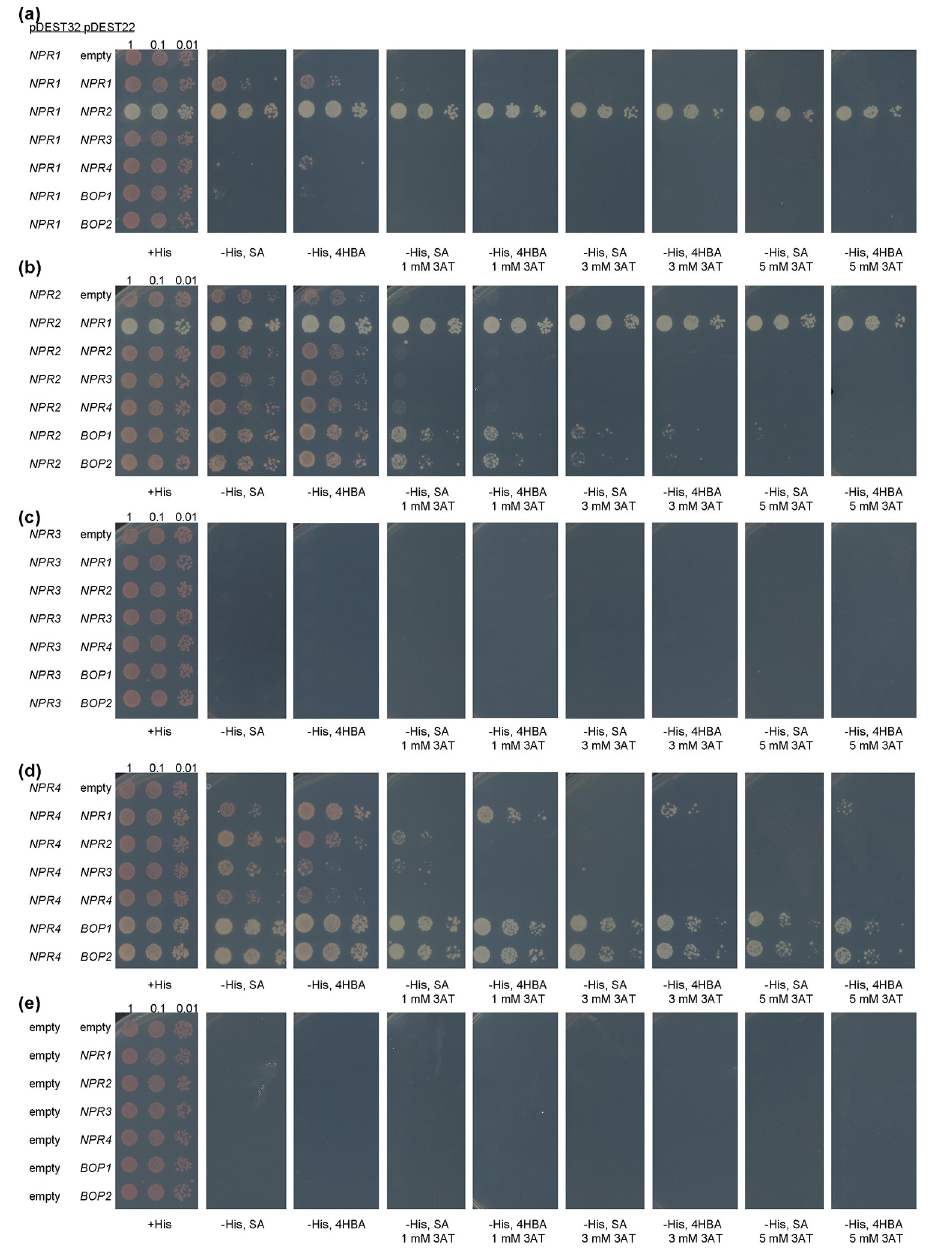
Fig 5. NPR1 paralogs in yeast two hybrid. (a) Interactions of NPR1 with the paralogs. (b) Interactions of NPR2 with the paralogs. (c) Interactions of NPR3 with the paralogs. (d) Interactions of NPR4 with the paralogs. (e) Controls of empty